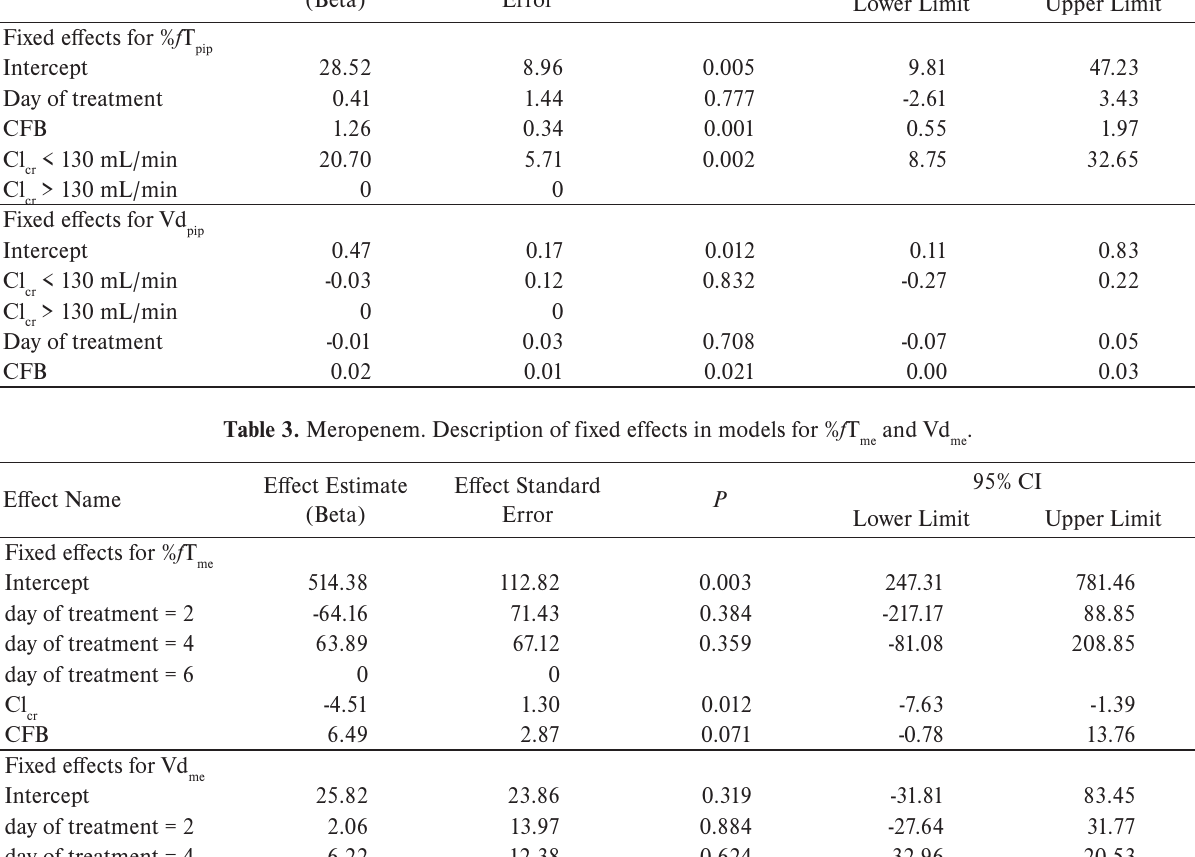
Table 2. Piperacillin. Description of fixed effects in models for % f T